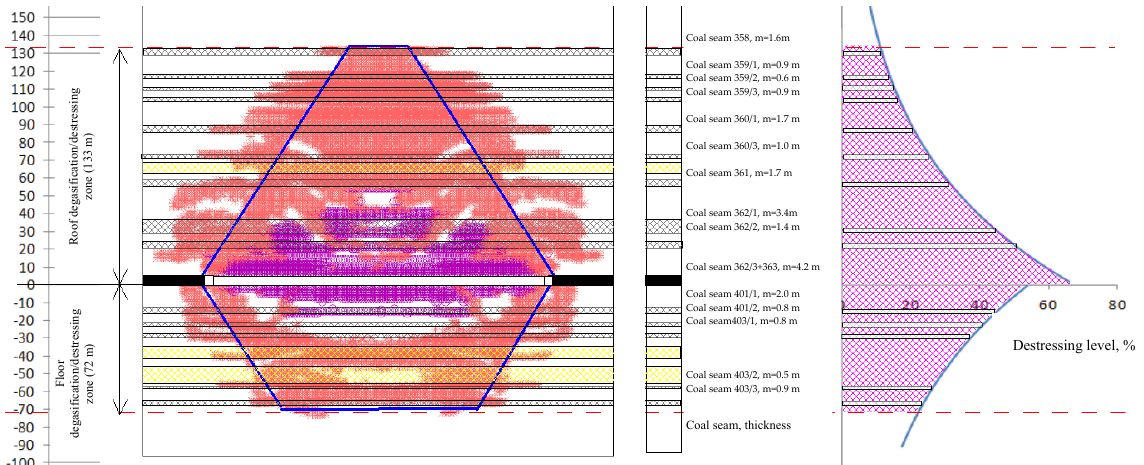
Figure 17. Destressing zone range calculation results for rock strata adjacent to longwall K-2 in coal seam 362/3 + 363 using FLAC2D (longwall length, L s = 186 m), including the implementation of rock mass degasification level distribution.